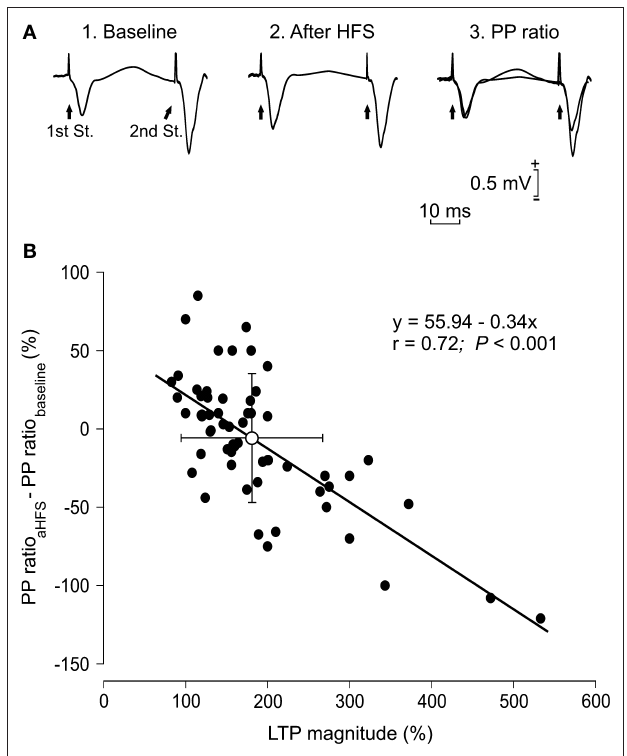
FIGURE 6 | Changes in PPF as a function of LTP evoked in CA1 pyramidal cells by HFS stimulation of Schaffer collaterals. (A) Representative examples (averaged three times) of fEPSPs evoked at the CA3-CA1 synapse by paired-pulse stimulation (40 ms interval) prior to (1. Baseline) and after (2. After HFS) HFS of Schaffer collaterals. The different facilitation evoked before and after HFS is noticed adjusting the fEPSP evoked by the 1st pulse (3. PP ratio). (B) A plot of LTP magnitude [determined as the increase (in percentage) of the 1st pulse after the HFS session with respect to baseline value] against the difference between PPF after HFS minus PPF during baseline recordings − PP (PP , in %). PP values were collected 15 min after HFS trains. aHFS baseline aHFS Each black circle corresponds to a different animal ( n = 60). The white circle indicates the mean value ± SD of the illustrated data for the two ( x , y ) axes. The presence of negative values on the Y axis indicates that the PPF after HFS reached values lower than for baseline